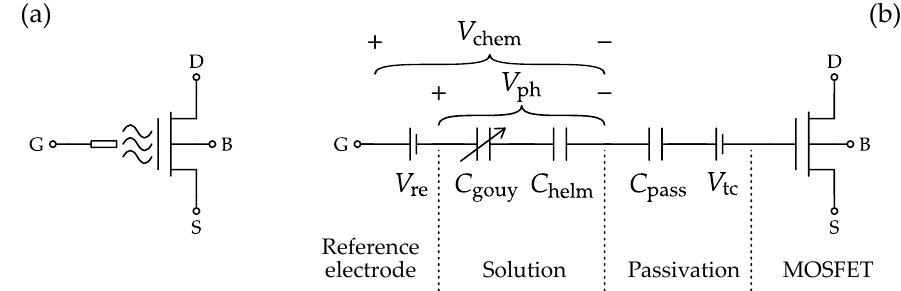
Figure 19. Ion-selective field-effect transistor (ISFET) symbol ( a ) and equivalent electrical model ( b